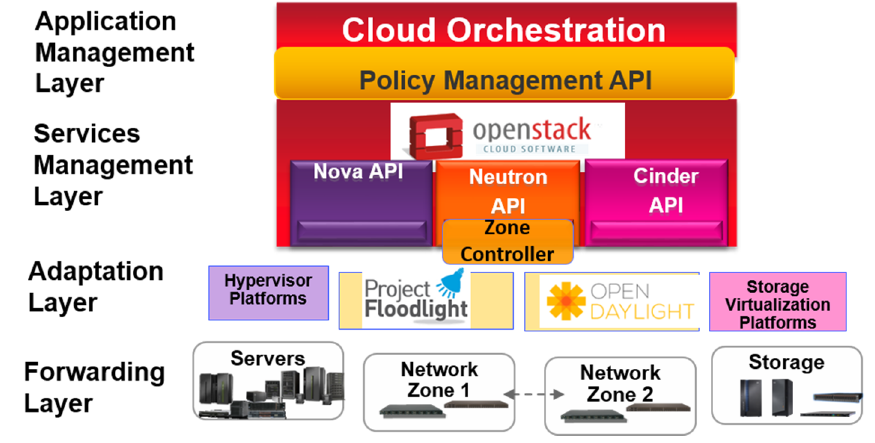
Figure 1. Software defined networking (SDN) optical network management